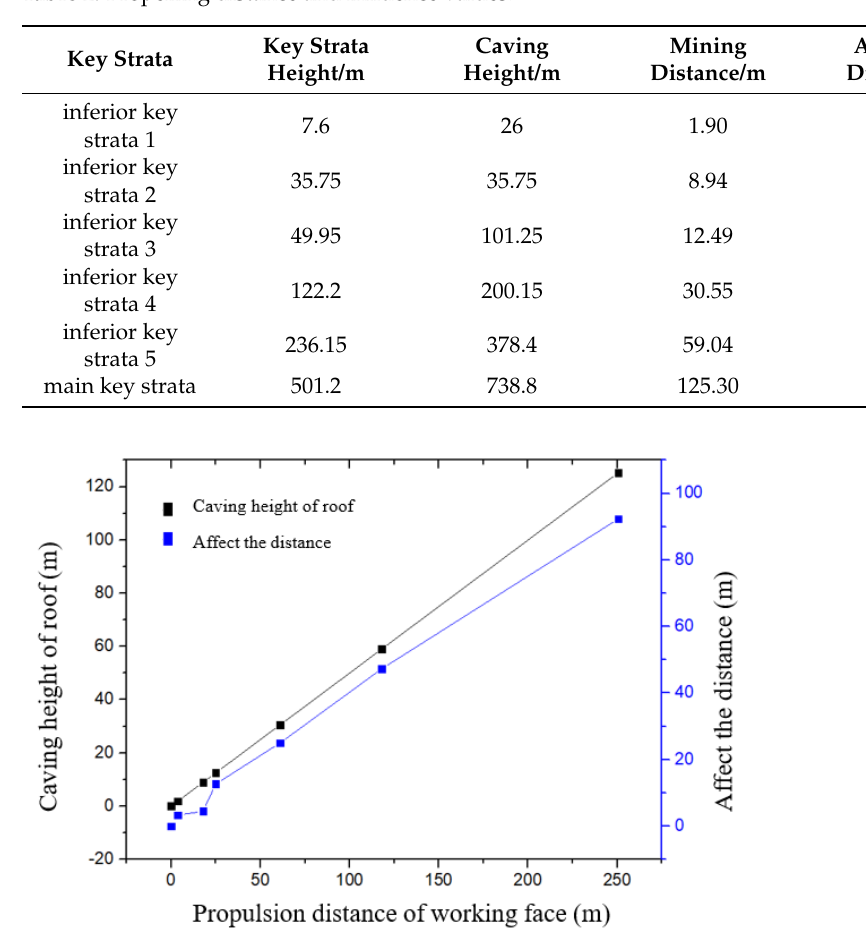
Figure 7. Relation between working face propel distance and roof caving height and influence dis- tance.